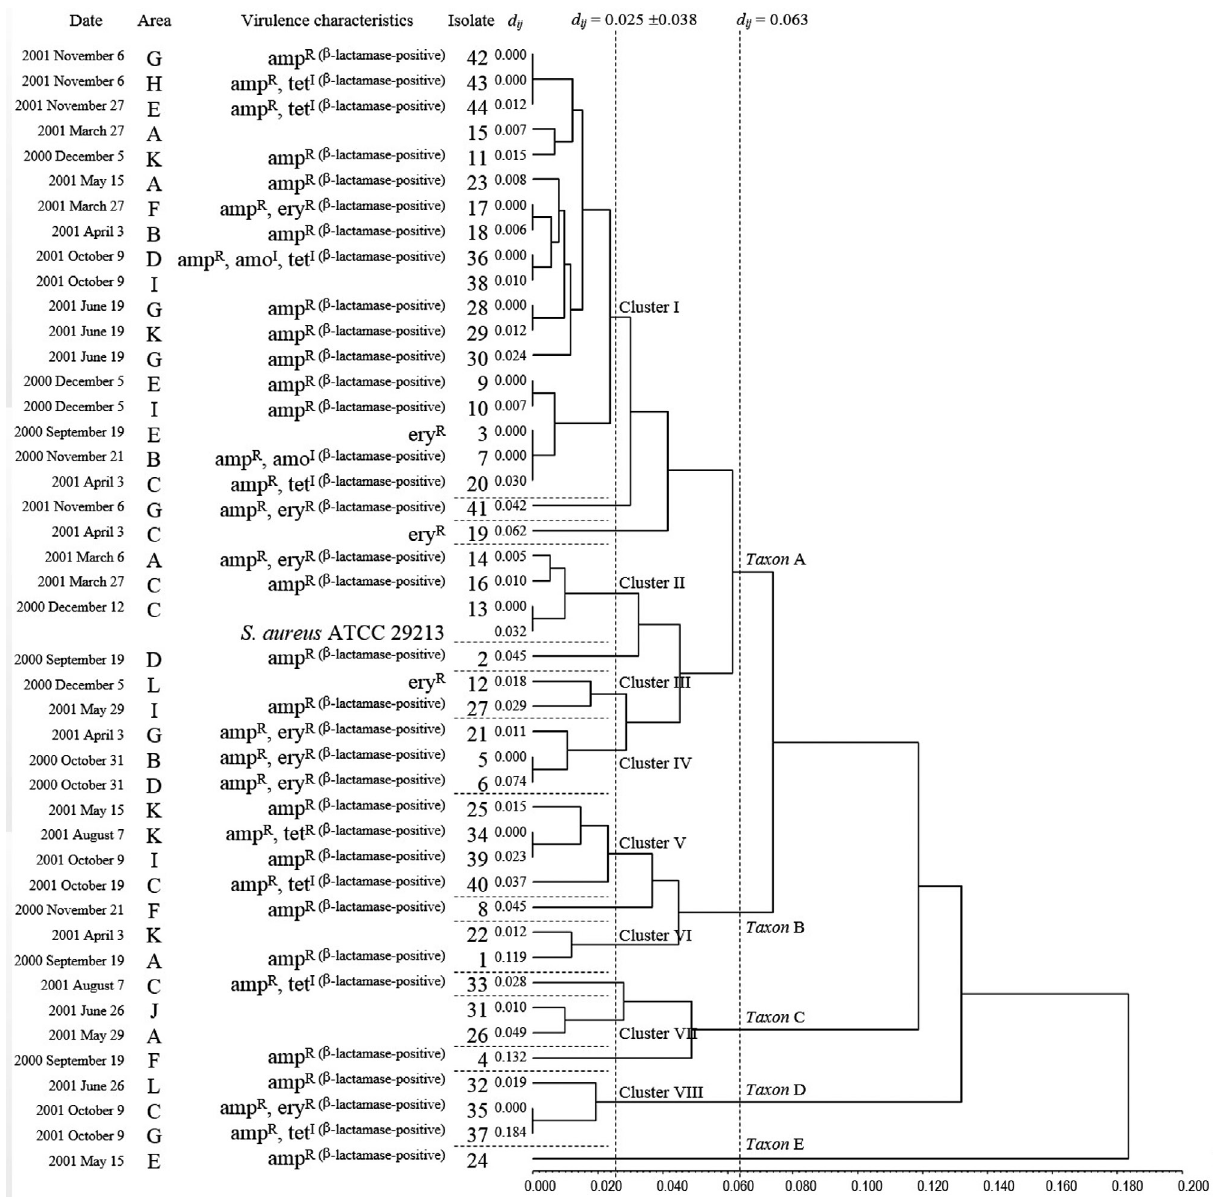
Figure 4- Genetic diversity of the 44 S. aureus isolates from the dental clinic environments (air) and the S. aureus type strain (ATCC ® 29213). UPGMA dendrogram ( r